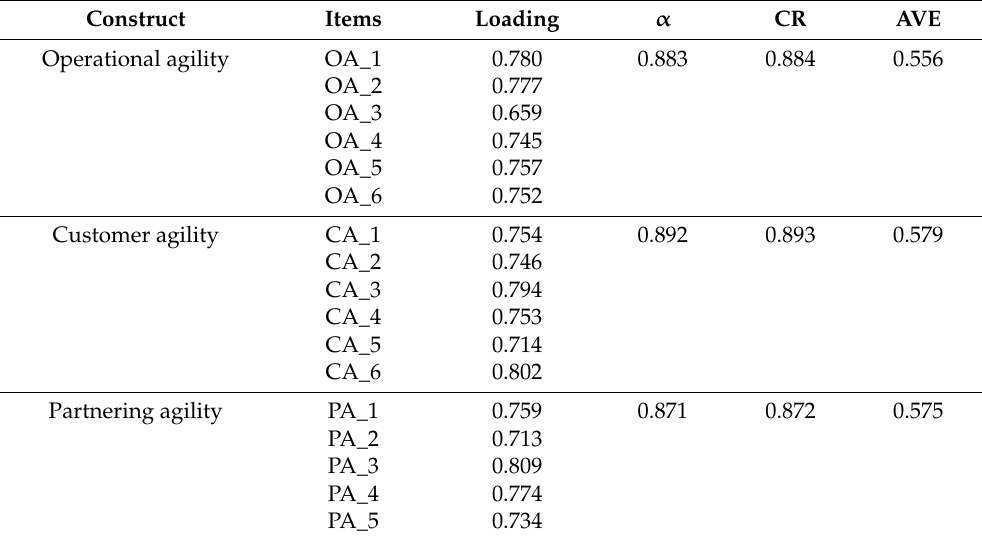
Table 1. Reliability and Validity